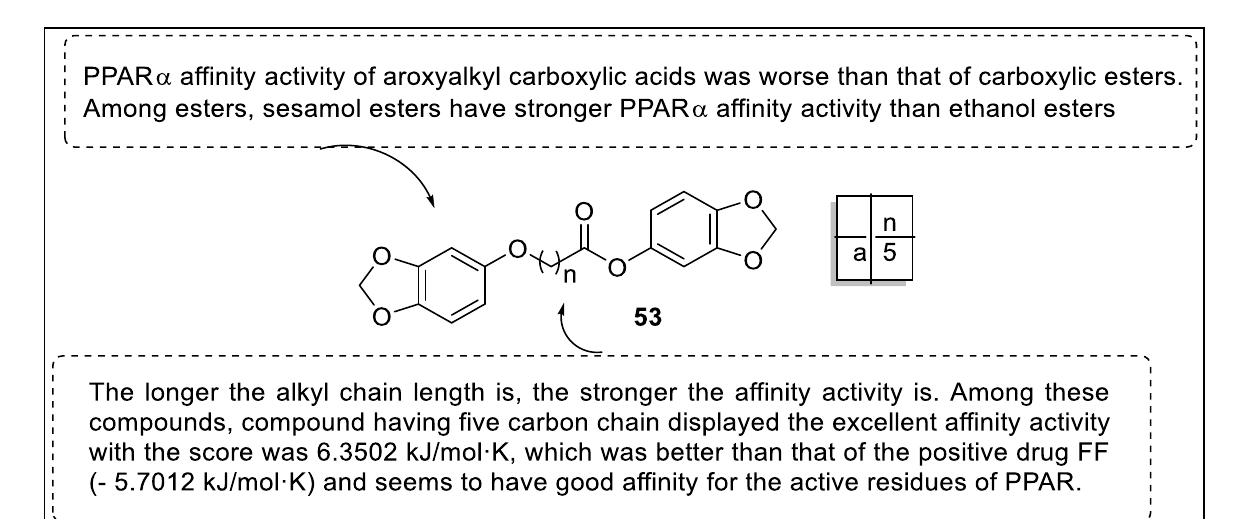
Figure 57. Structural activity relationship of 1,3-benzodioxole hybrids as potent PPAR ligands.